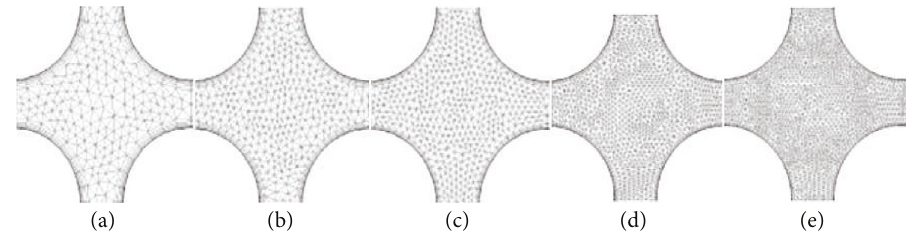
Figure 13: Mesh section in the areas where there are no fi ns.